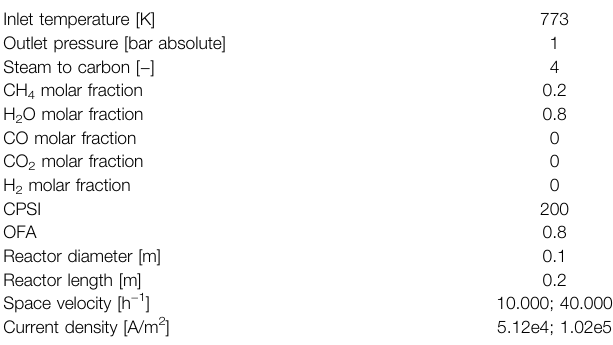
TABLE 4 | Operative conditions for simulations in section with Honeycomb Monoliths an Adiabatic e-MSR Unit. Inlet temperature [K]